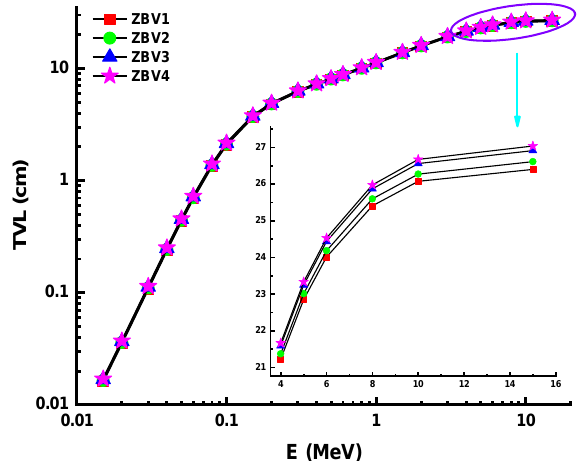
Figure 7. Variation of tenth-value layer (TVL) against photon energy for all glasses.